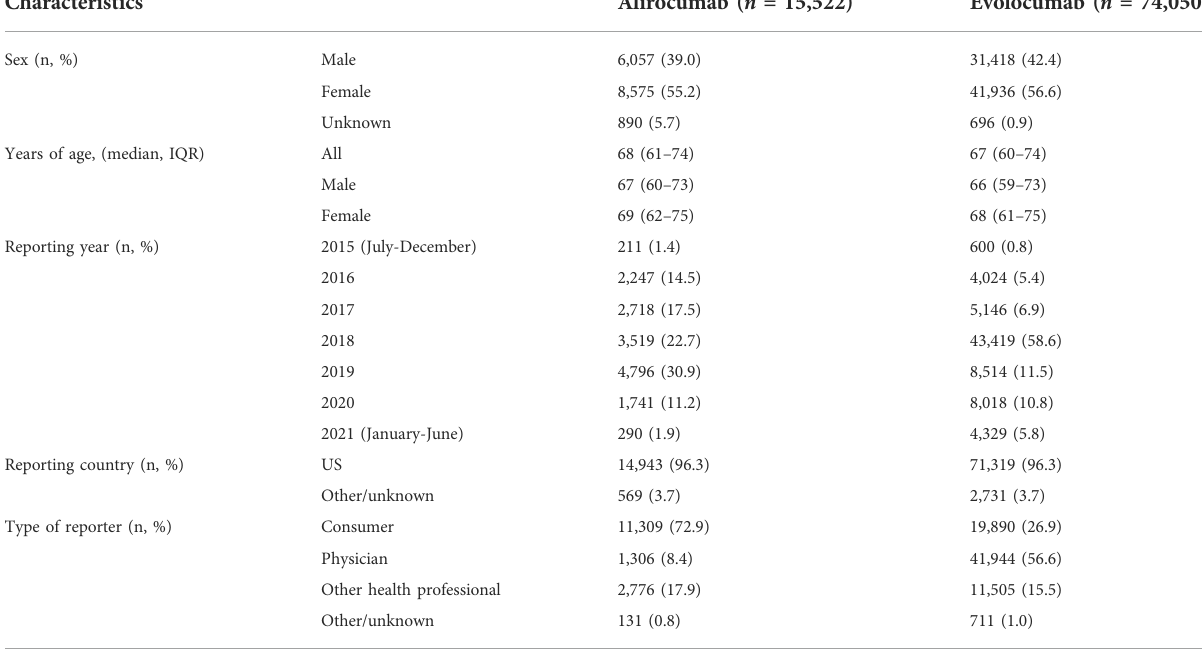
TABLE 1 Characteristics of AE reports associated with PCSK9 inhibitors from July 2015 to June 2021.